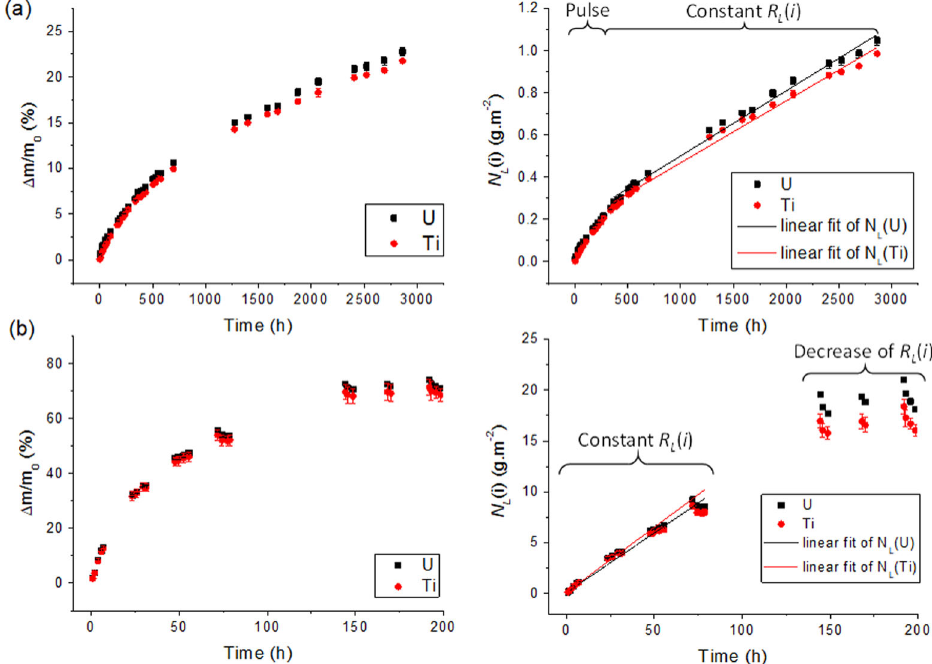
Fig. 1 Released U and Ti during the dissolution of brannerite in 2 mol/L H 2 SO 4 with 2.8 g/L of Fe(III). Evolution of the relative mass losses Δ m 2 ) obtained during the dissolution of synthetic brannerite samples in 2 mol/L H i / m 0 (%) and of the normalized weight losses N L (i) (g/m solution with 2.8 g/L of Fe(III) at 25 °C ( a ) and at 80 °C ( b ).